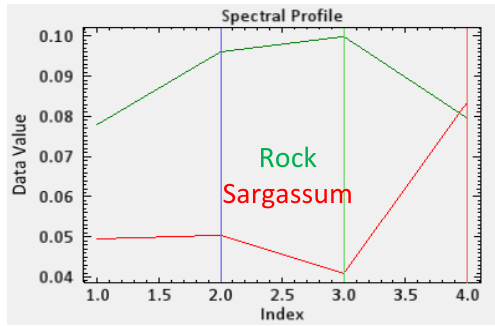
Figure 4. Spectral profile of the seaweed and rock